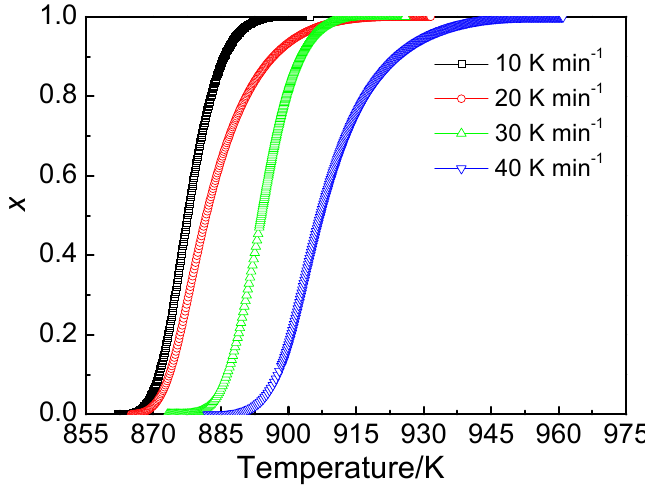
Figure 5. The x - T curves of the Fe 68 Nb 6 B 23 Mo 3 glassy alloys under various heating rates. According to the Ozawa - Flynn - Wall (OFW) equation, the local activation energy E ( x )